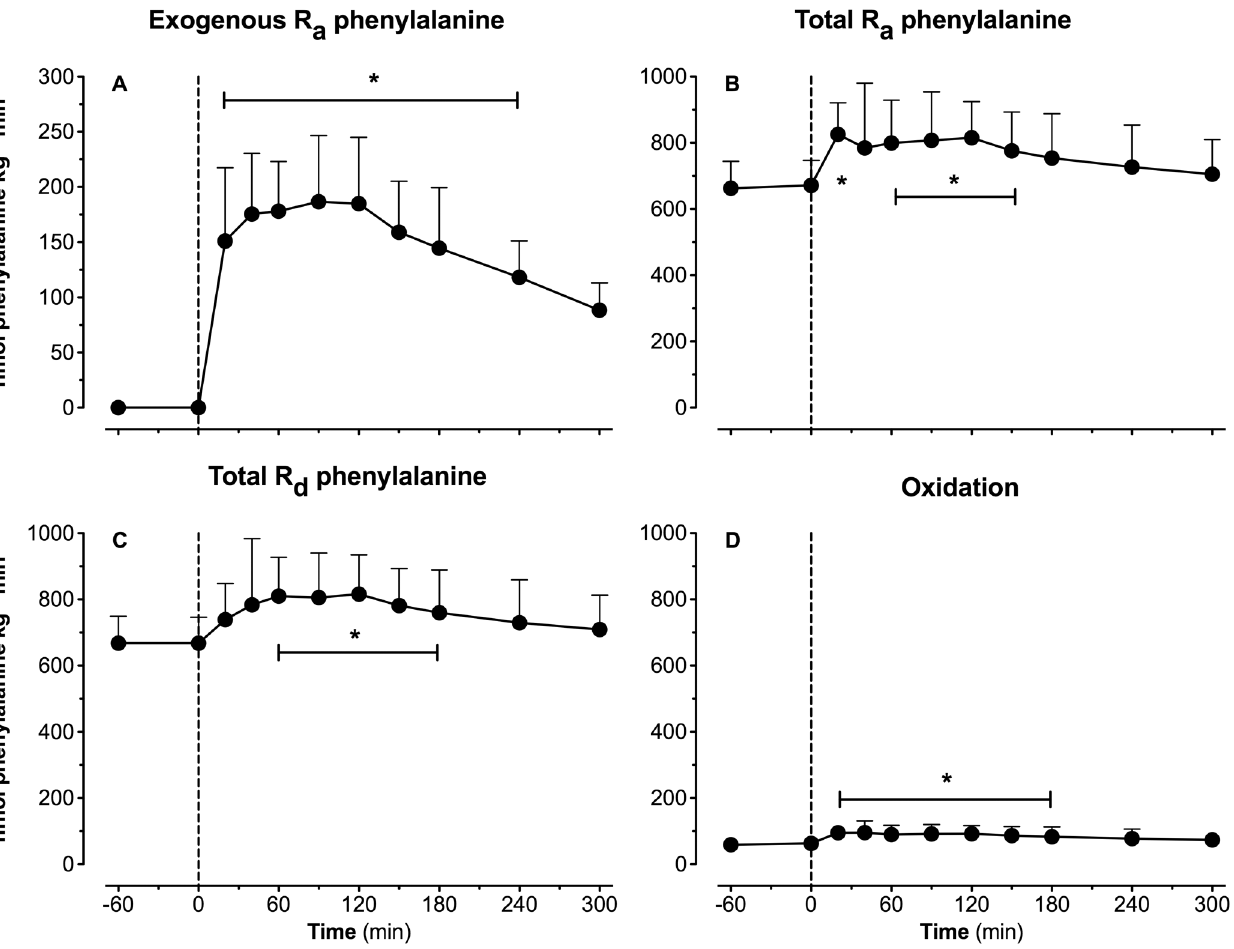
Fig 5. Plasma amino acids kinetics. Exogenous phenylalanine rate of appearance (R a ) (A), total phenylalanine R a (B), total phenylalanine rate of disappearance (R d ) (C) and phenylalanine-to-tyrosine conversion (oxidation) (D). Values represent means ± SEM. * Indicates a significant difference compared to baseline level (t = 0 min), P < 0.05.